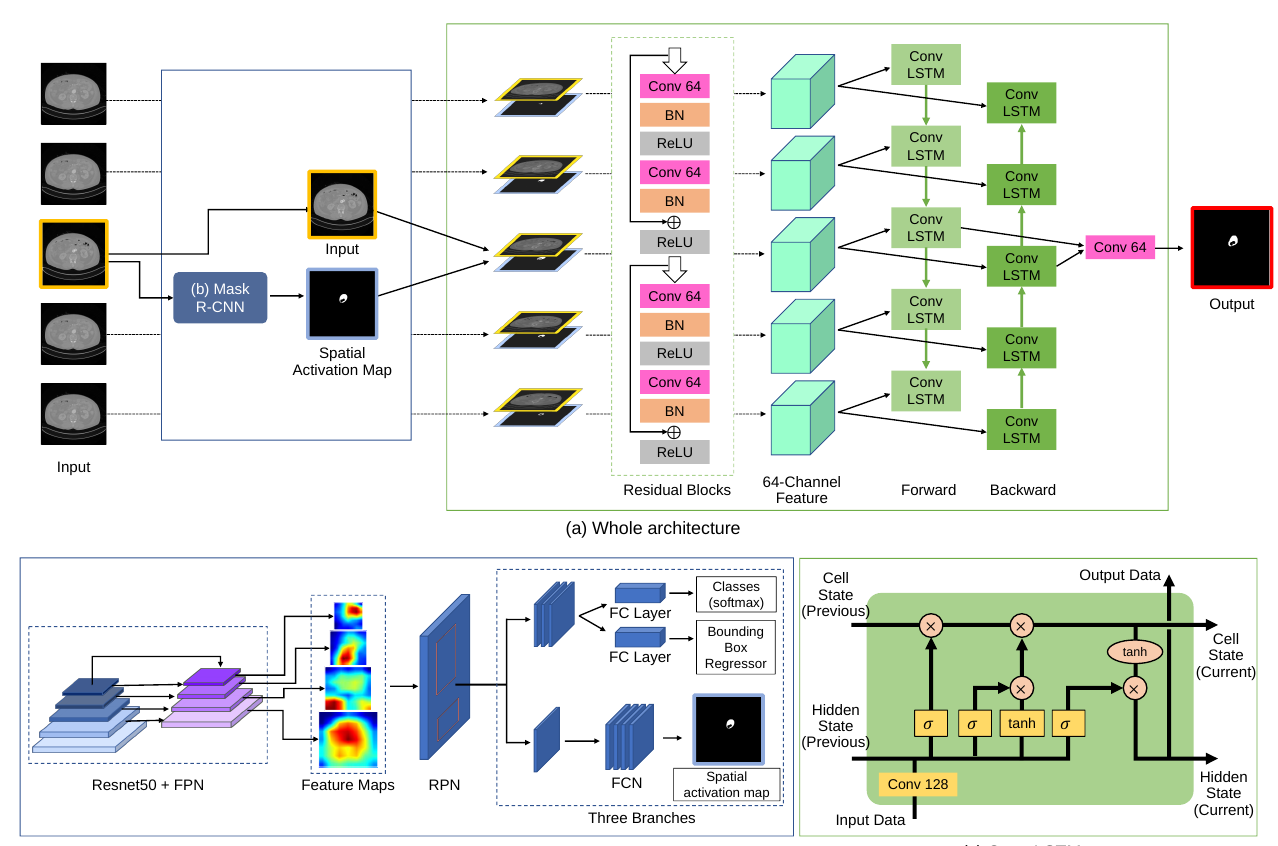
Figure 2. The overview of our Bi-CLSTM-based thrombus ROI segmentation method. Our Bi-CLSTM method inputs a sequence of the five pairs: a pair of the target image and its spatial activation map and the four neighbor pairs. Our Bi-CLSTM-based method performed bi-directional feature integration among the pair sequence. Mask R-CNN was used to extract the spatial activation maps of the individual